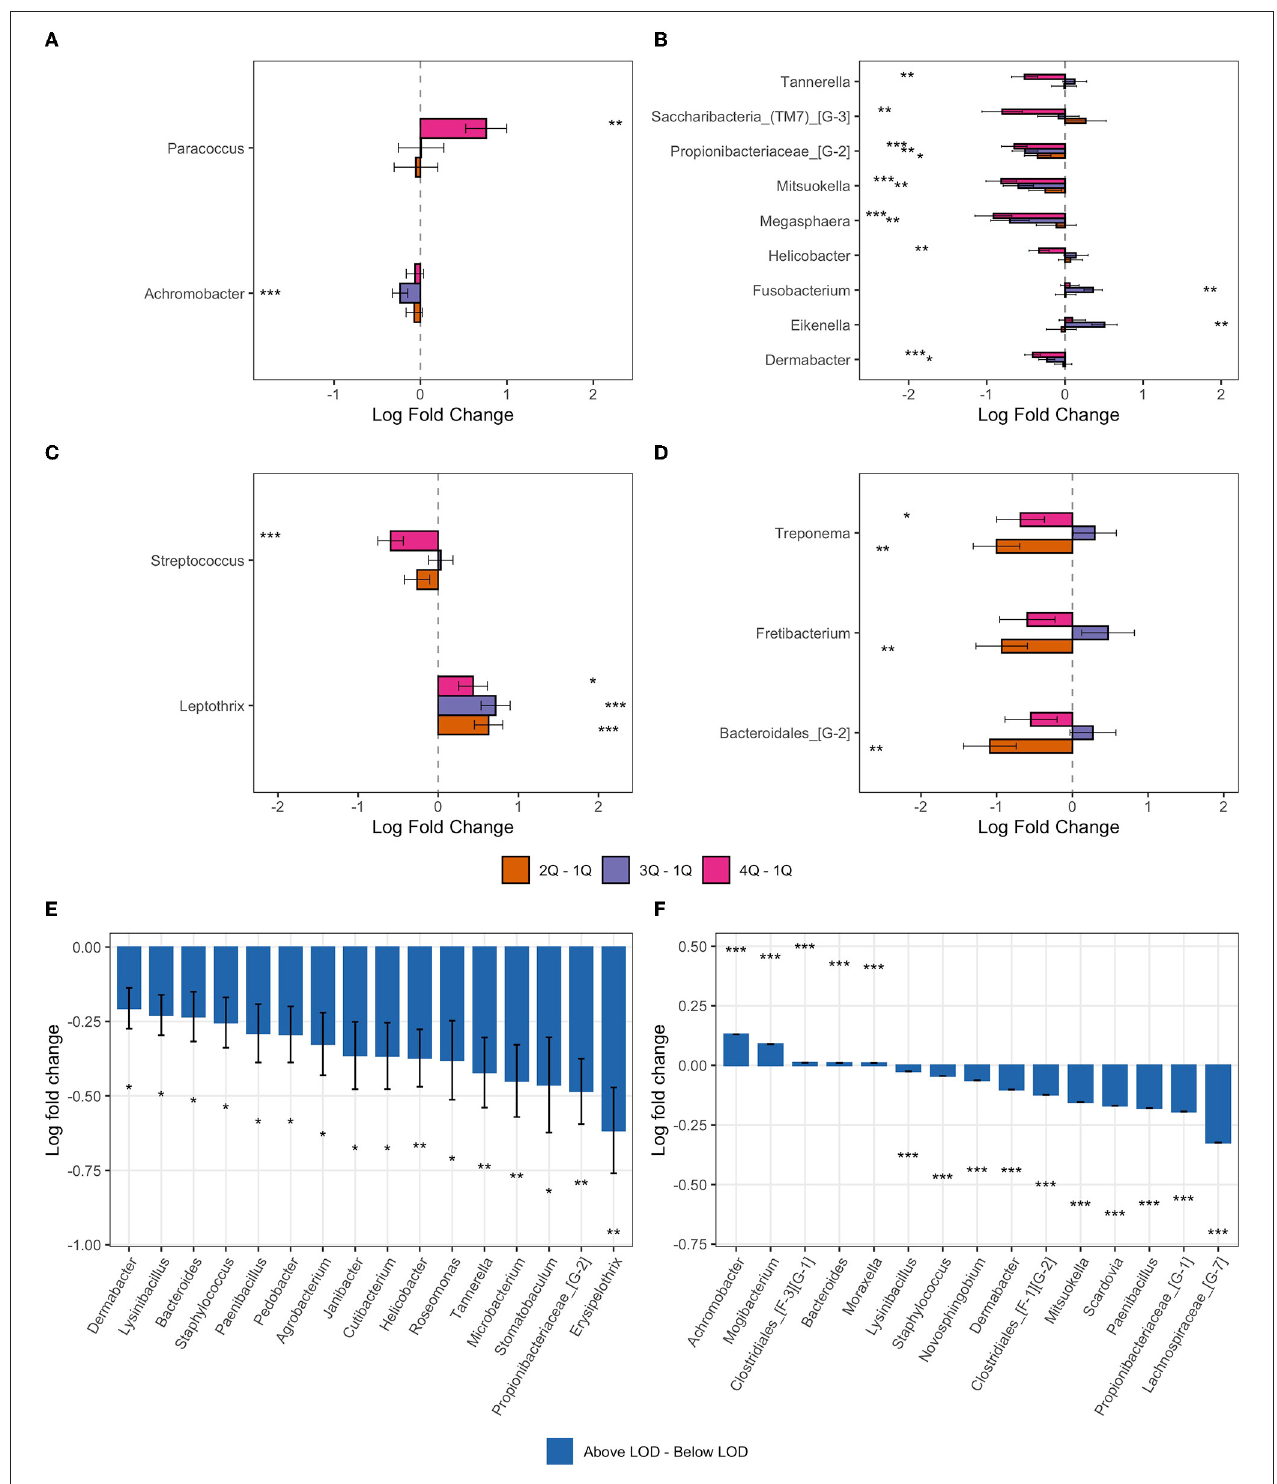
FIGURE 5 | Bar plot of differentially abundant genera obtained from ANCOM-BC pairwise analysis. Data are represented by log-fold change (shown as a column) ± SE (shown as error bars). All log fold changes with p < 0.05 are indicated, *significant at 5% level of significance; **significant at 1% level of significance; and ***significant at 0.1% level of significance. (A) Ethylparaben; (B) propylparaben; (C) bisphenol A; (D) 2,4-DCP; (E) butylparaben; and (F) triclocarban.